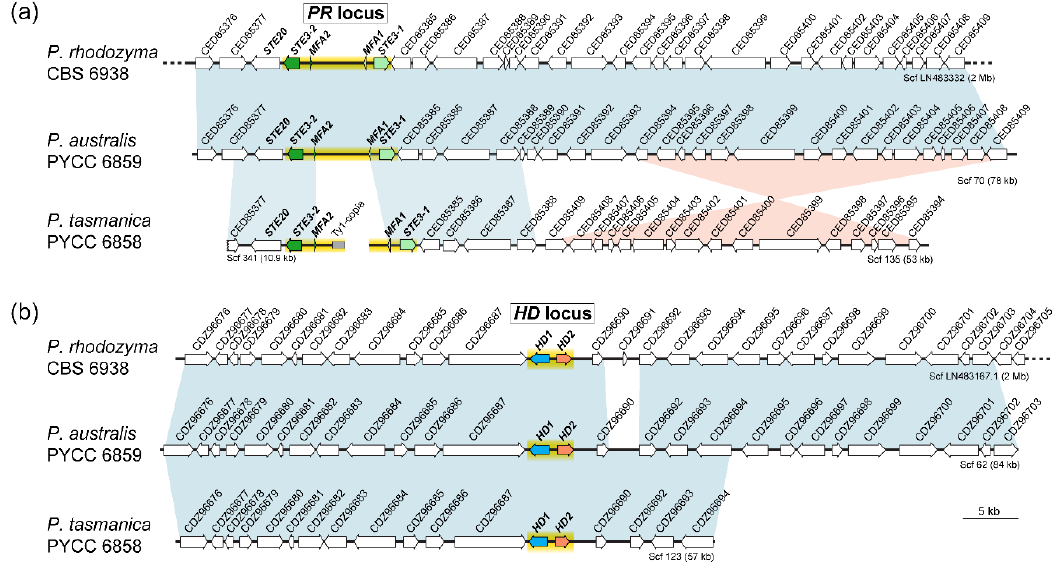
Figure 4. Organization of the mating-type ( MAT) loci in the three Phaffia species. Scaffolds encompassing PR ( a ) and HD ( b ) genes in the different Phaffia species are represented. Genes are depicted as arrows indicating the direction of transcription and are identified by the protein accession number of their putative orthologs in P. rhodozyma CBS 6938. Mating-type genes, including pheromone receptor genes ( STE3 ), pheromone precursor genes ( MFA ), and homeodomain transcription factor genes ( HD1 and HD2 ) are color-coded, while other genes are depicted in white. The regions spanning the proposed HD and PR loci are highlighted in yellow. In P. tasmanica , the PR locus is located at the end of two scaffolds, which are possibly interrupted by transposable elements. Scaffolds ending with a dotted line indicate that the scaffold is only partially represented. Blocks of synteny with orthologs in the same or inverted orientation are depicted by blue or pink bars, respectively.